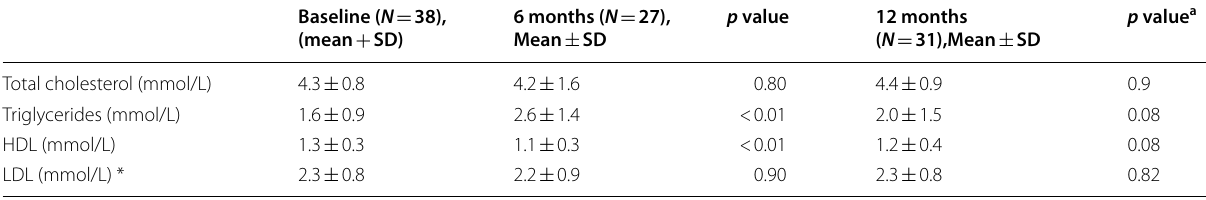
Table 5 Changes to serum lipids during study